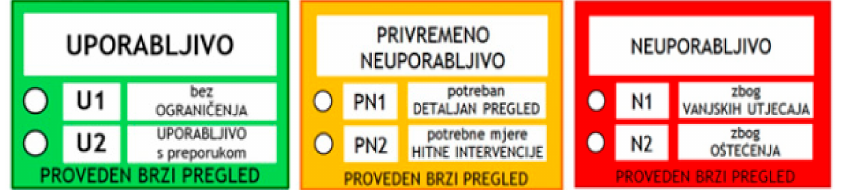
Figure A1. Six categories of usability divided into three original labels (in